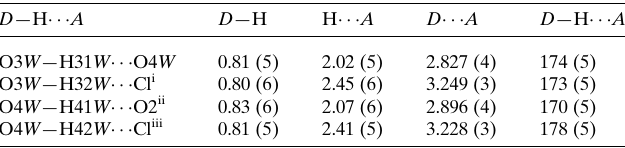
Table 1 Hydrogen-bond geometry (A˚ , (cid:4)